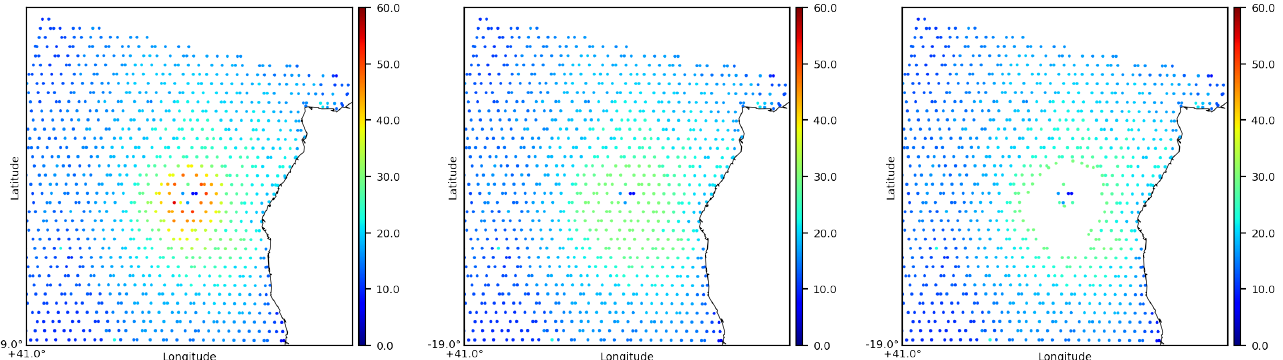
Figure 25. SAR wind speed observations assimilated within 51° E–55° E, 10° S–14° S with observations in experiments SAR_12km_2ms ( left ), SAR_12km_max30 ( middle ) and SAR_12km_no30 ( right ). Units are m · s − 1